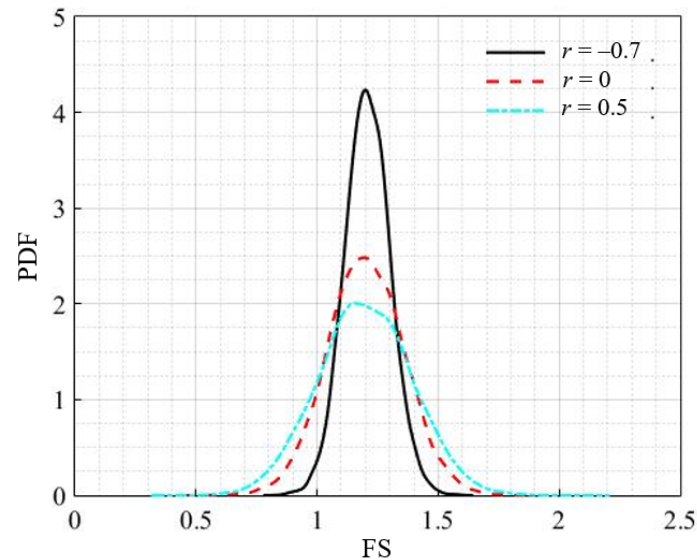
Figure 17. PDFs for different cross ‐ correlation coefficients.